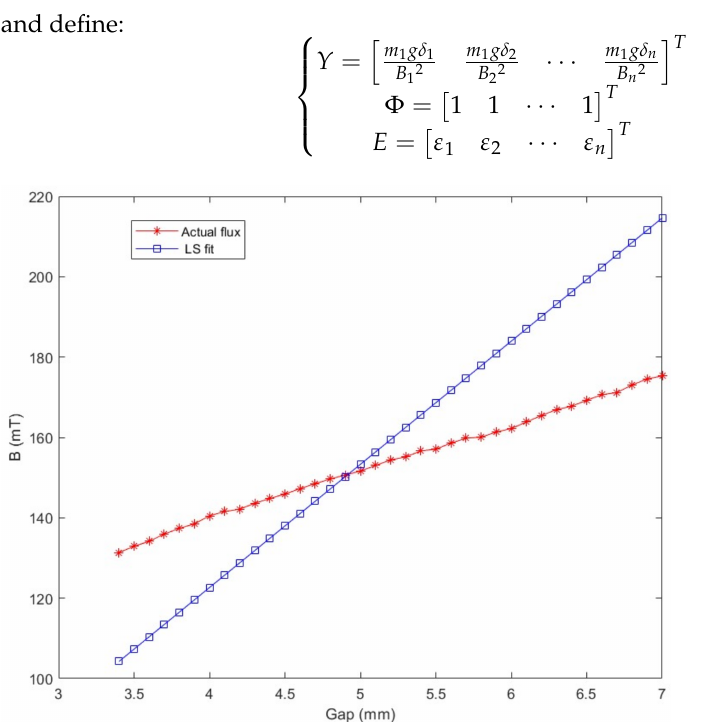
Figure 5. Comparison of the actual magnetic flux and the magnetic flux estimated by Equation (16).